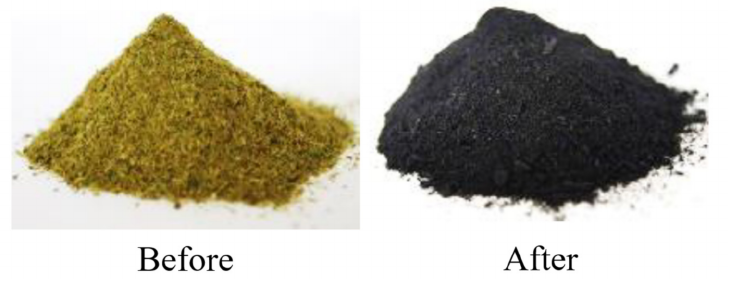
Figure 4. Stages of chemical modification.